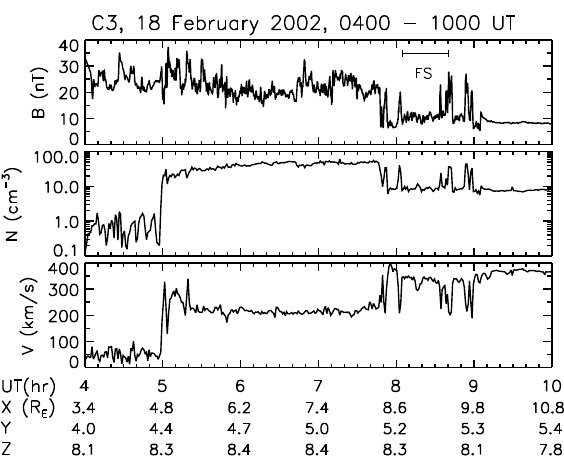
Fig. 1. Measurements of the magnitude of magnetic field from FGM, ion density and bulk velocity from CIS-HIA made by Clus- ter 3 from 04:00 to 10:00 UT on 18 February 2002. “FS” between 08:05 and 08:40 UT stands for an interval of the foreshock wave